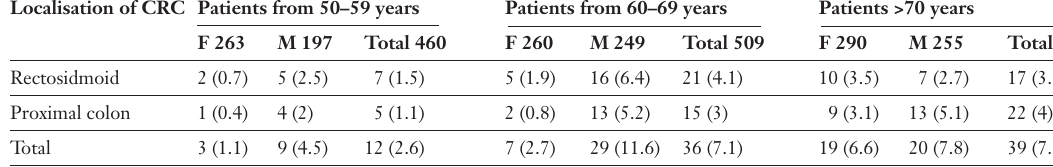
Distribution of advanced lesions according to site and age (data given in raw numbers and % in gender-specific age-category, n = 156 advanced lesions in 140 patients).